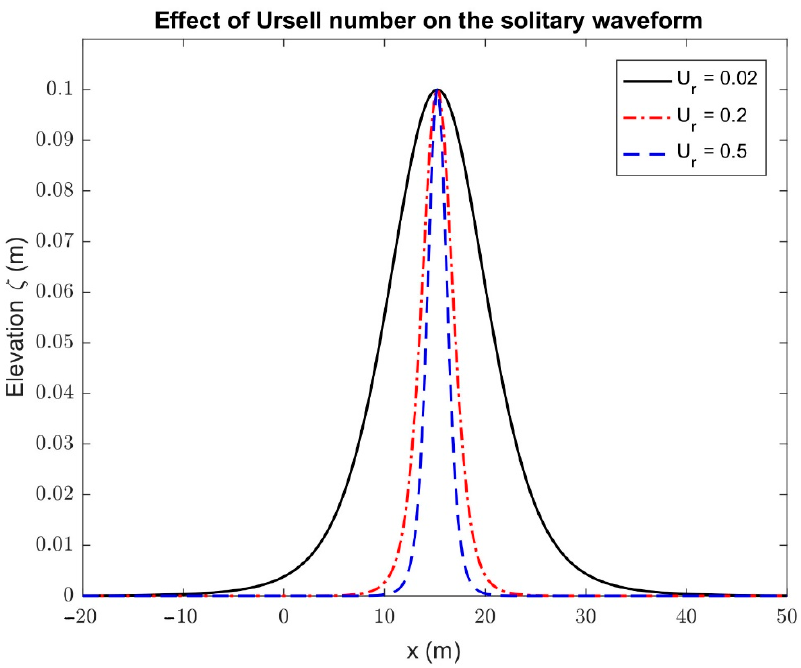
Figure 18. Effect of Ursell number on the solitary wave profiles in the outer region versus water plane length x (m).